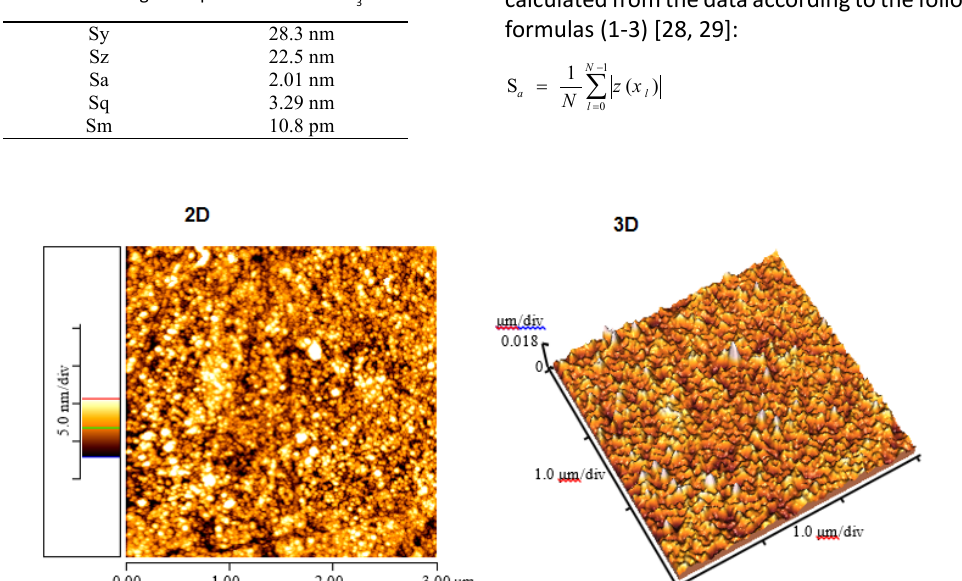
Table 3: Roughness parameters for WO